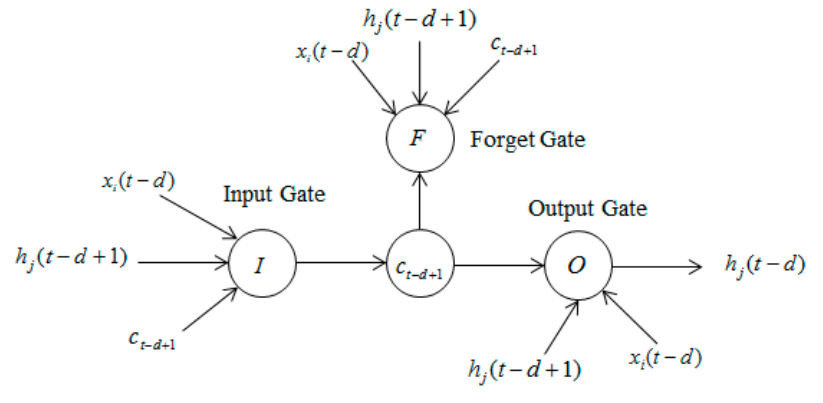
Figure 2. Structure of LSTM neuron.